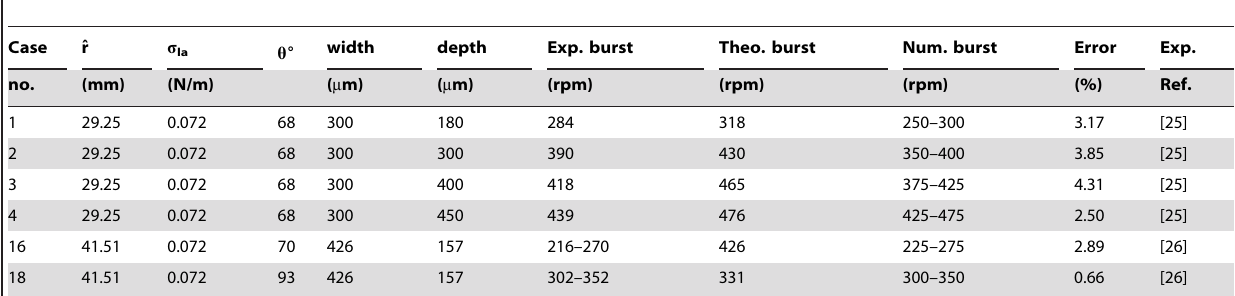
Table 2. Comparison between the numerical and experimental burst frequencies with dimensions and positions of the capillary valves on the